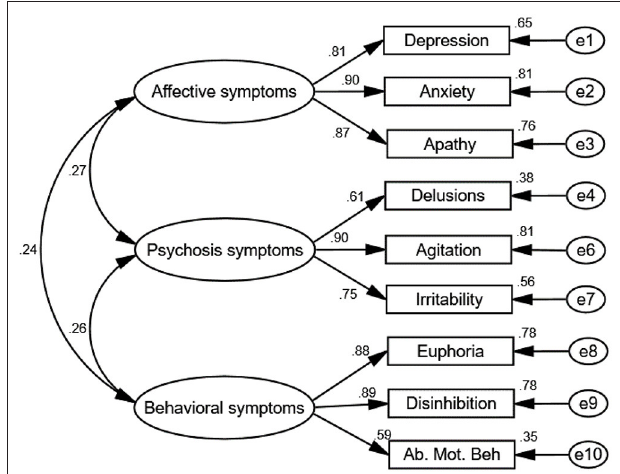
FIGURE 2 | Path diagram of the confirmatory factor analysis. The goodness-of-fit indices of the modified model were as follows: χ 2 / df = 2.06, GFI = 0.96, CFI = 0.98, NFI = 0.96, IFI = 0.98, and RMSEA = 0.06, which indicate a good fit. Three factors were verified from the CFA: Factor 1 described affective symptoms, including depression, anxiety, and apathy. Factor 2 described psychosis symptoms, including delusions, agitation, and irritability. Factor 3 described behavioral symptoms, including disinhibition, euphoria, snf aberrant motor behavior. Rotation converged in nine